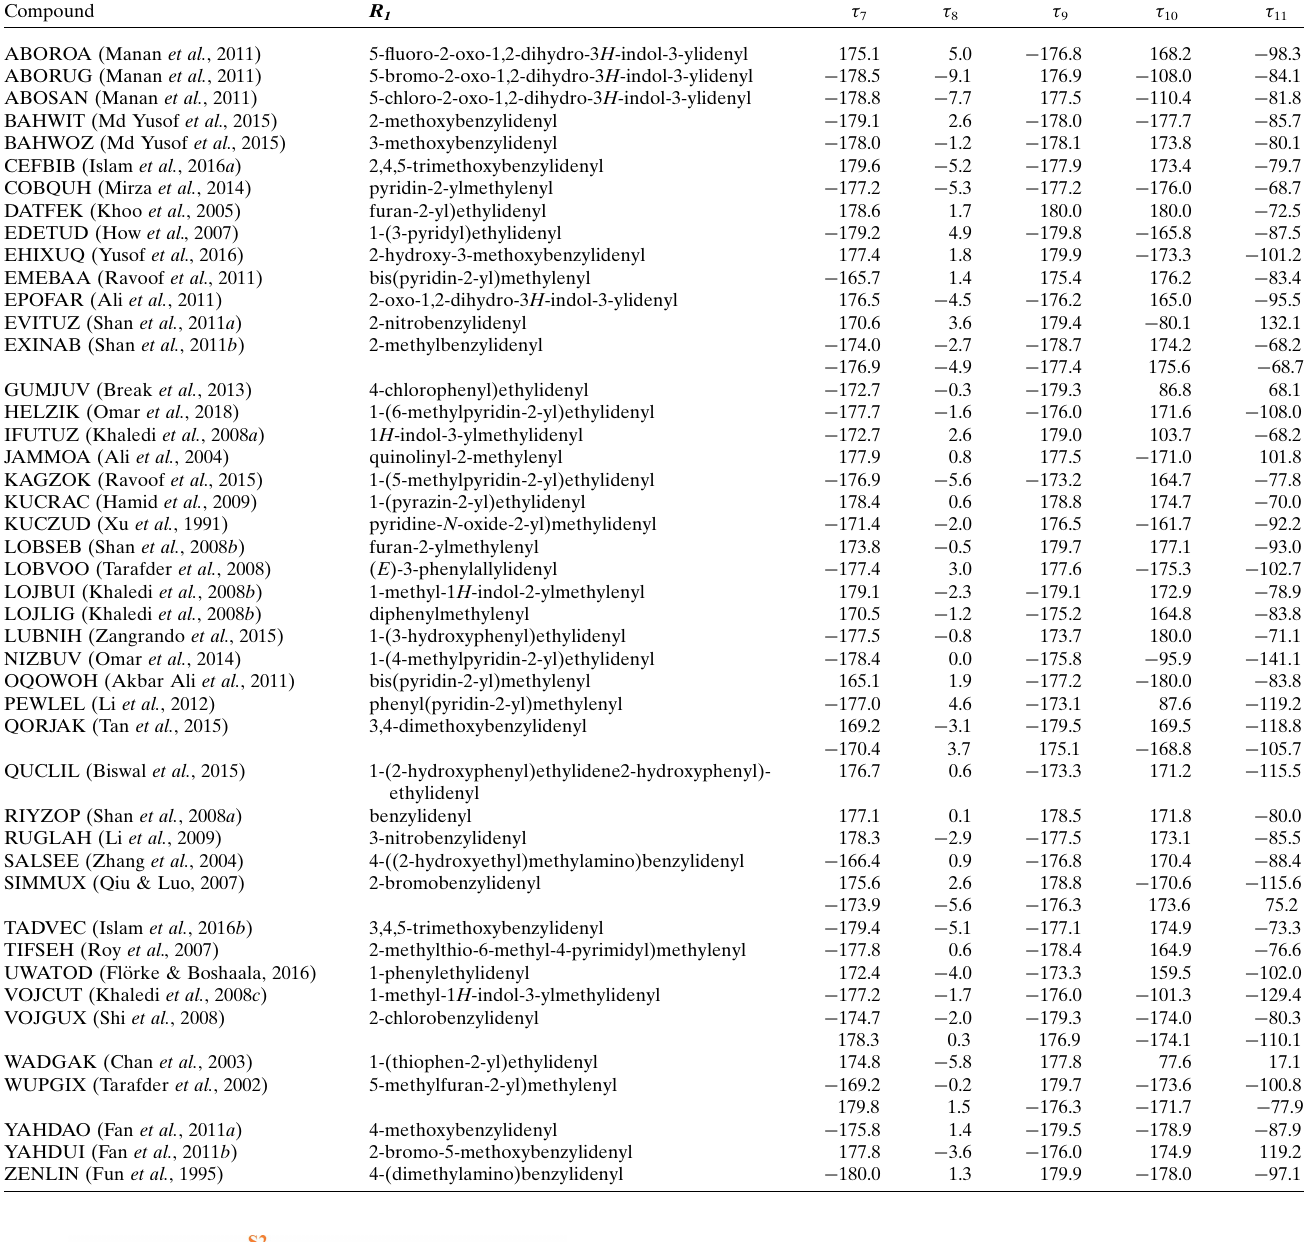
Table 4 Torsion angles (cid:3) 7 , (cid:3) 8 , (cid:3) 9 , (cid:3) 10 and (cid:3) 11 ( (cid:2) ) in related hydrazinecarbodithioates. Two sets of torsion angles are stated for compounds EXINAB, QORJAK, SIMMUX, VOJGUX and WUPGIX because there are two molecules in their asymmetric units. The molecule with disorder in the structure of compound ZENLIN was omitted from this table. Compound R 1 ABOROA (Manan et al. , 2011)